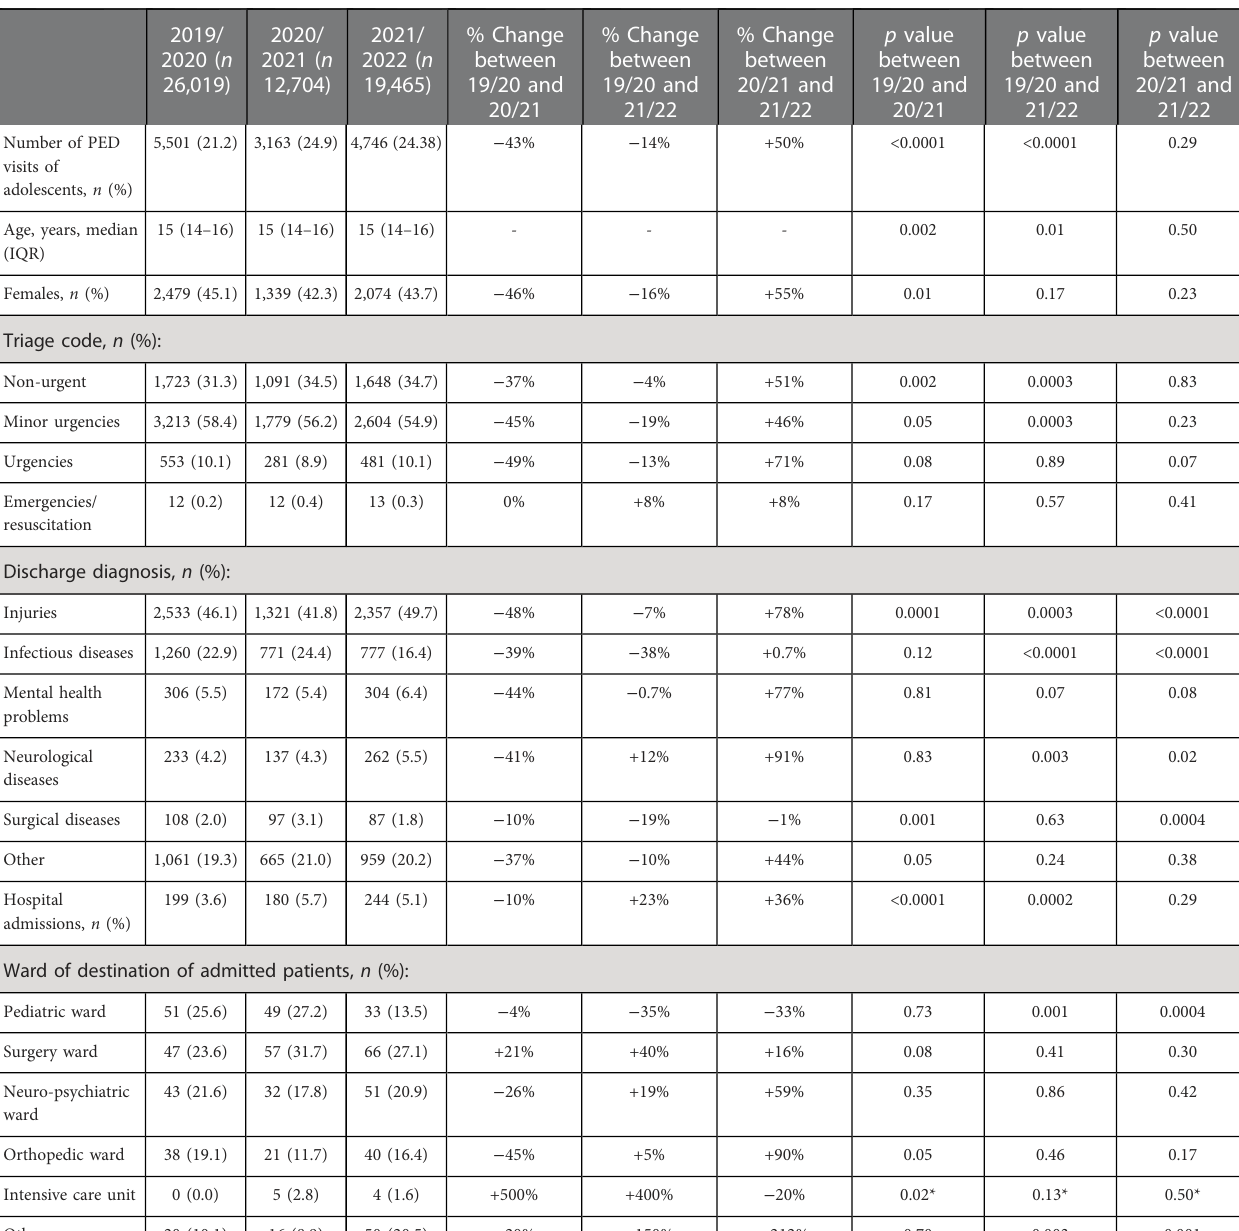
TABLE 1 Main features of adolescents ’ PED visits during the pre-pandemic, the fi rst and the second year of the COVID-19 pandemic.